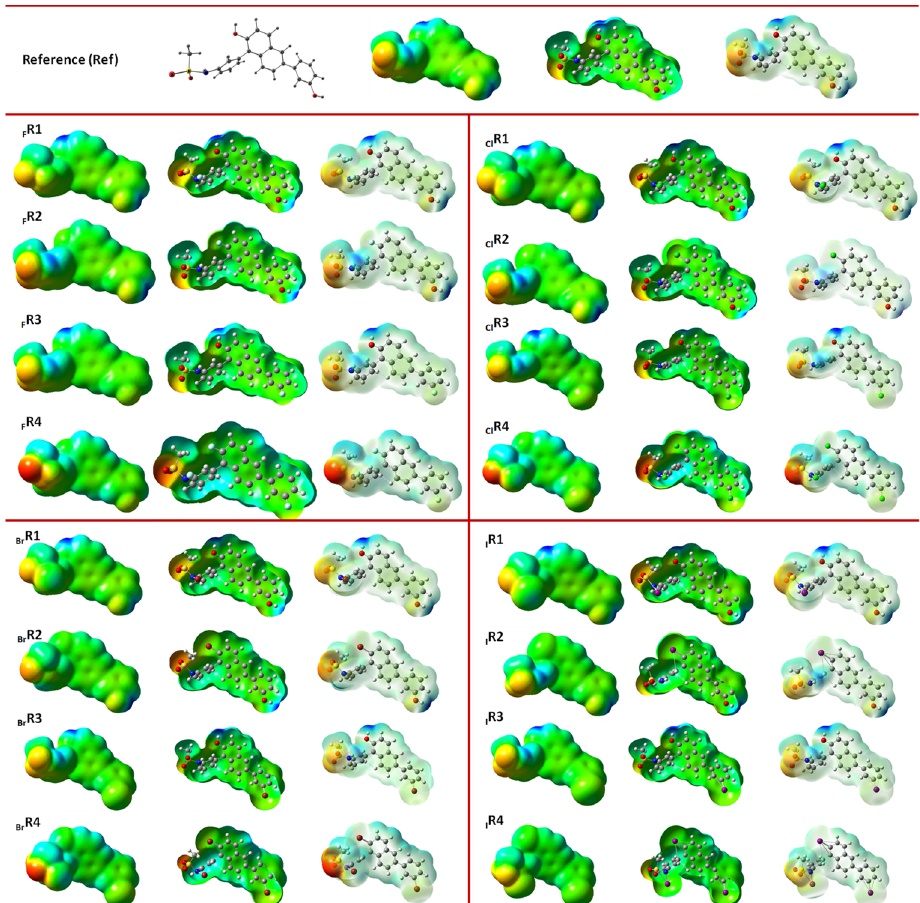
Figure 4. Molecular electrostatic potential analysis (MESP) for all newly designed molecules.